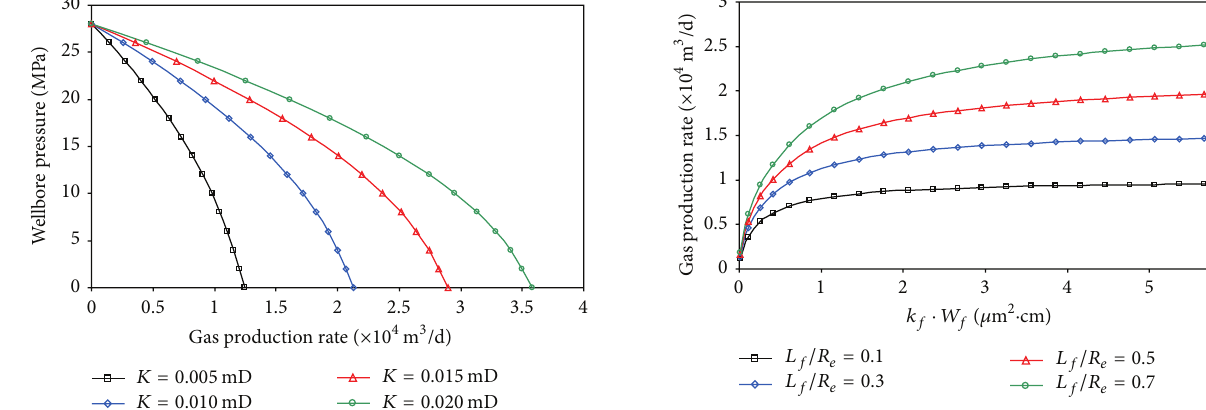
Figure 6: Effect of matrix permeability 𝐾 on productivity.